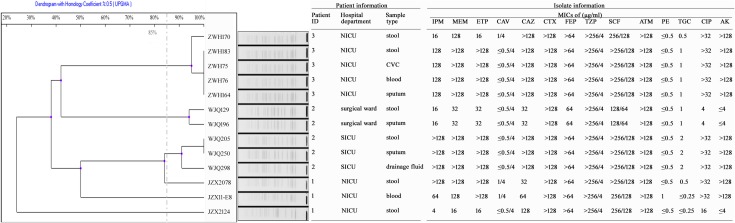
Antimicrobial susceptibility and PFGE profiles of 13 CRKP isolates collected from three inpatients. IPM, Imipenem; MEM, Meropenem; ETP, Ertapenem; CAV, Ceftazidime-avibactam; CAZ, Ceftazidime; CTX, Cefotaxime; FEP, Cefepime; TZP, Piperacillin-tazobactam; SCF, Cefoperazone-sulbactam; ATM, Aztreonam; PE, colistin; TGC, Tigecycline; CIP, Ciprofloxacin; AK, Amikacin; CVC, central venous catheter.